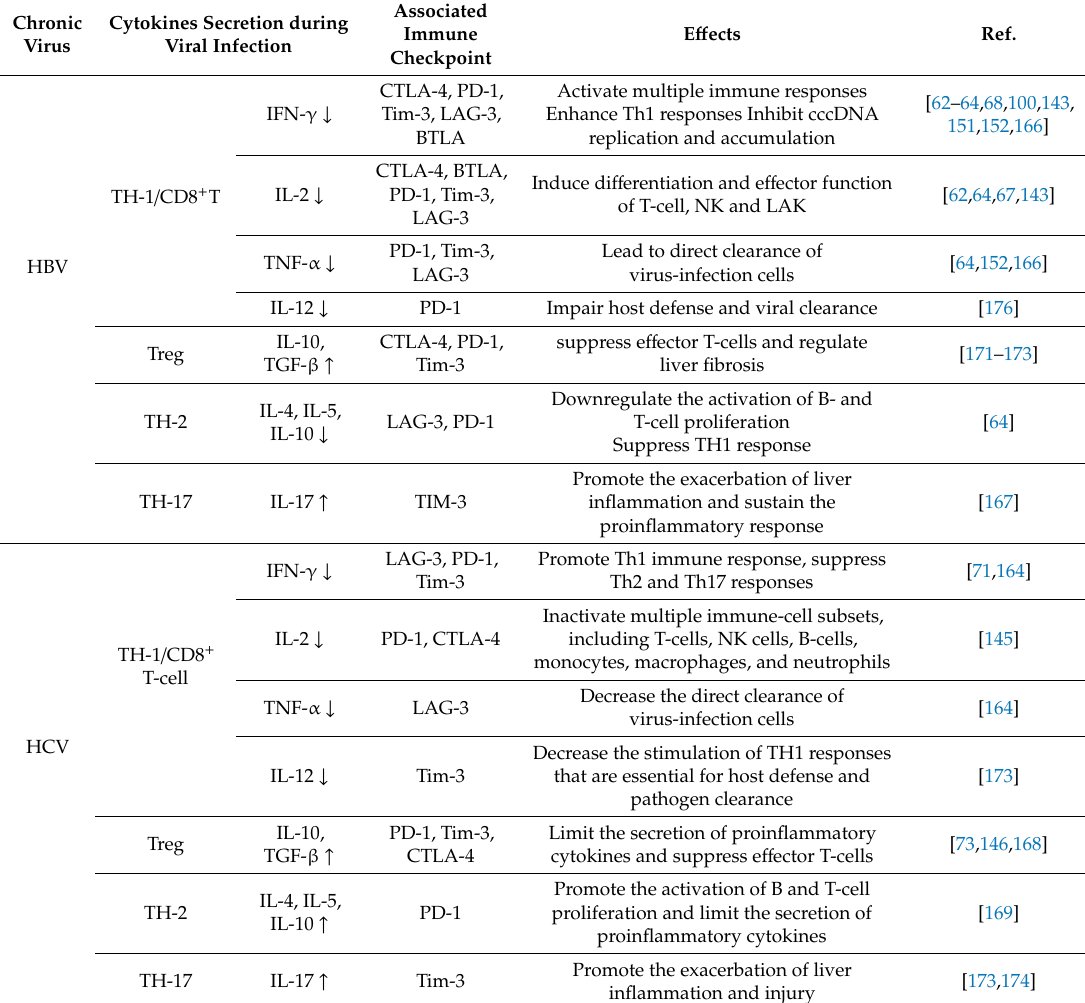
Table 4. Cytokine secretion altered by immune checkpoints in chronic virus infection. Chronic